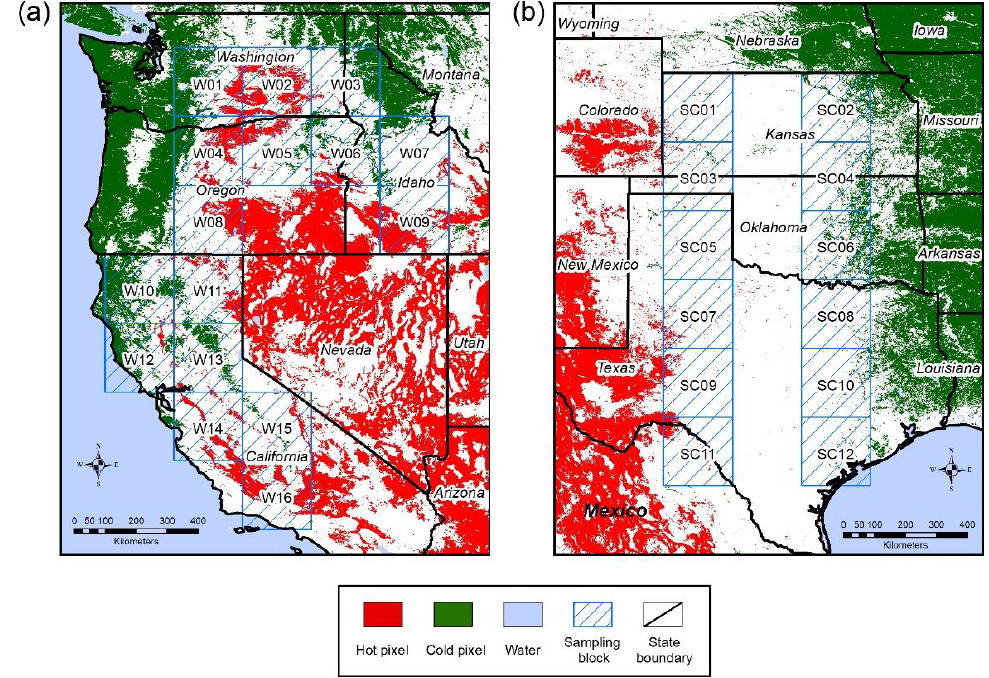
Figure 3. Sampling blocks used for retrieving LST from hot and cold pixels to calculate observed dT ( dT o ). The date of the hot and cold pixels in the map is 12–19 July. ( a ) West Coast region. ( b ) South-Central region.